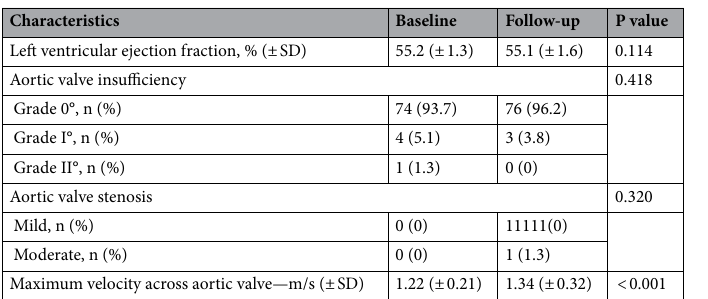
Table 1. Patients’ characteristics and cardiovascular risk factors of study participants. BMI body mass index, SD standard deviation, BP blood pressure, bpm heart rate.